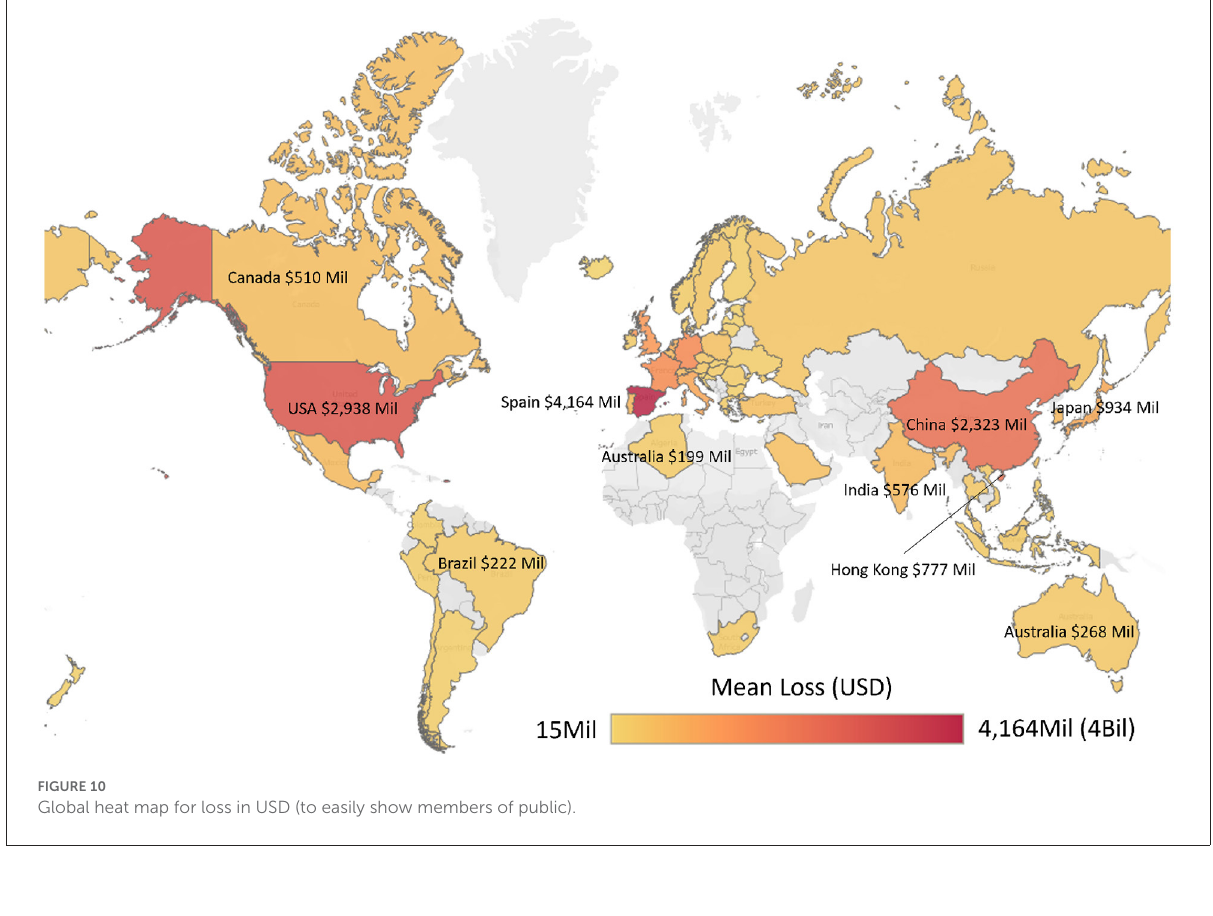
FIGURE10 Global heat map for loss in USD (to easily show members of public).